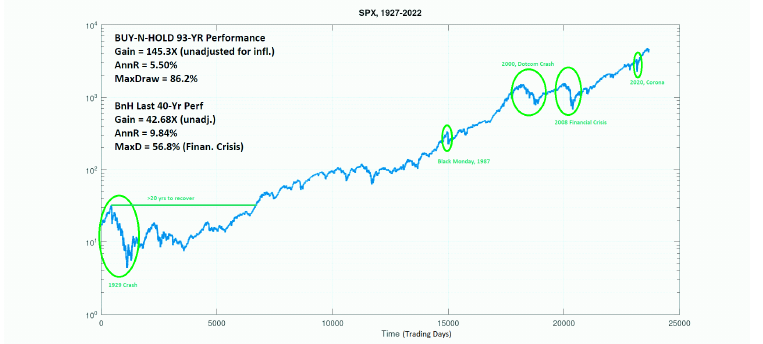
Figure 7. S&P500 (SPX), 30 December 1927–1 April 2022, graphed for 94 years (tested 93+ years due to MAs). The market trends upwards, but it has many dips and valleys. The buy-and-hold (BnH) performance is given for the past 93 and 40 years. For convenience, the x-axis is now time in trading